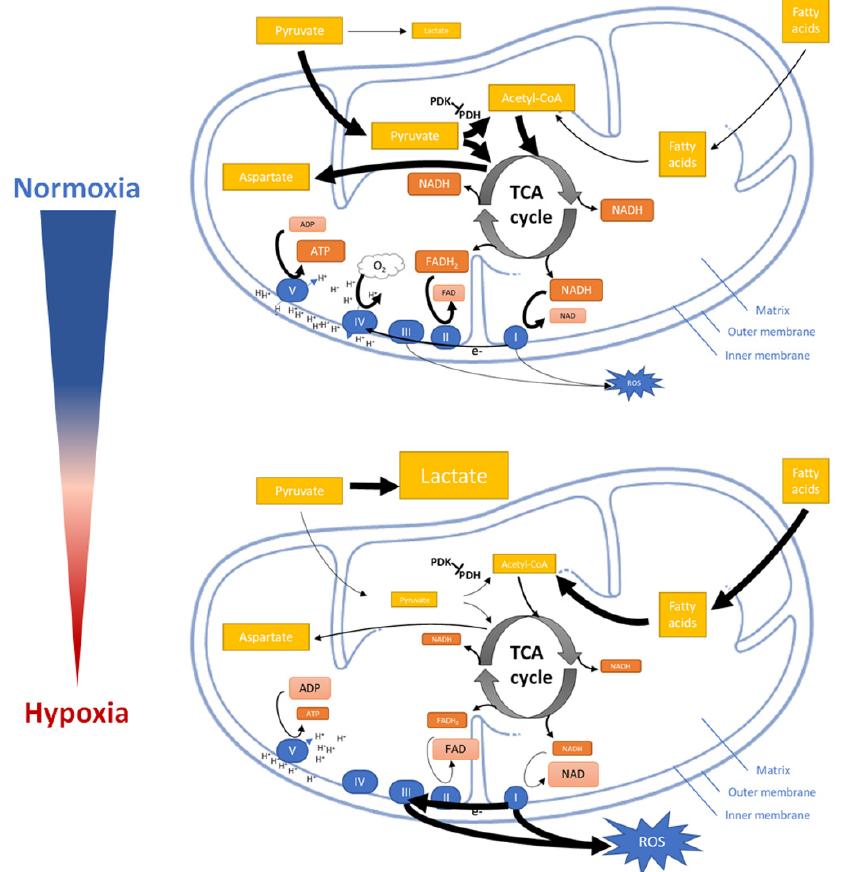
Figure 4. Impact of hypoxia on mitochondrial functions. Under normoxia, pyruvate is shifted into the mitochondria and catalyzed to Acetyl coenzyme A (Acetyl-CoA) as a substrate for the TCA cycle (tricarboxylic acid cycle) to synthesize energy-rich reductants (NADH and FADH 2 ) which drive the electron flux through the ETC and provide Aspartate. Under hypoxia, pyruvate is catalyzed to lactate while only few amounts of Acetyl-CoA are provided by fatty acid oxidation to the TCA. Only low amounts of energy-rich reductants and ATP are produced. The lack of the final electron acceptor (oxygen) leads to ROS generation during electron flux through the ETC. (Large arrows indicate higher flux; smaller arrows indicate lower flux; larger icons indicate higher amounts of intermediates; smaller icons indicate lower amounts of intermediates). Figure was modified from Servier Medical Art, licensed under a Creative Common Attribution 3.0 Generic License